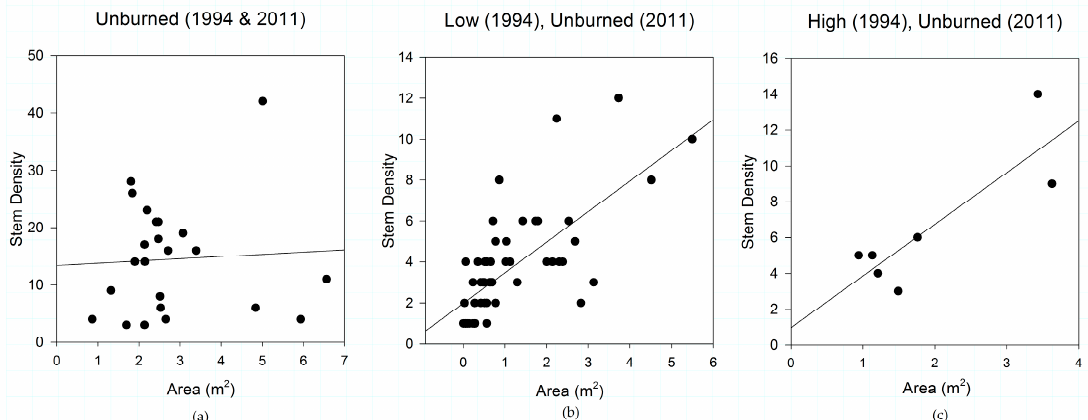
Figure 6. Shrub patch structural relationships of ( a ) plots that did not experience fire in 1994 or 2011; ( b ) plots that experienced low-severity fire in 1994 and went unburned in 2011; and ( c ) plots that experienced high-severity fire in 1994 and went unburned in 2011, in the study area. The organizing effect of increasing fire severity observed in plots burned in 2011 (Figures 3 and 5) can be observed in plots burned in 1994 and unburned in 2011. The organizing effect of fire severity on shrub patch structure may persist for